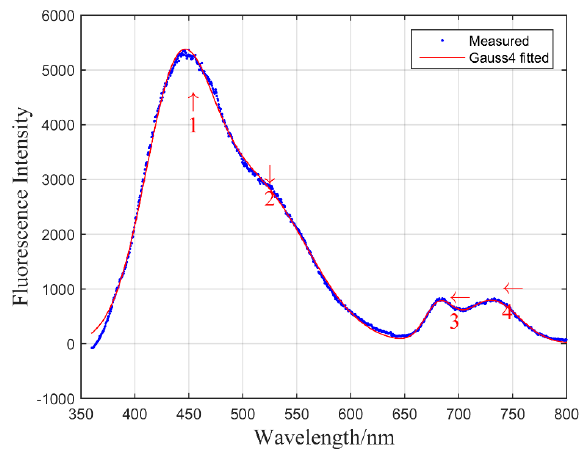
Figure 1. Example of a fluorescence spectrum and its approximation by a Gaussian model.